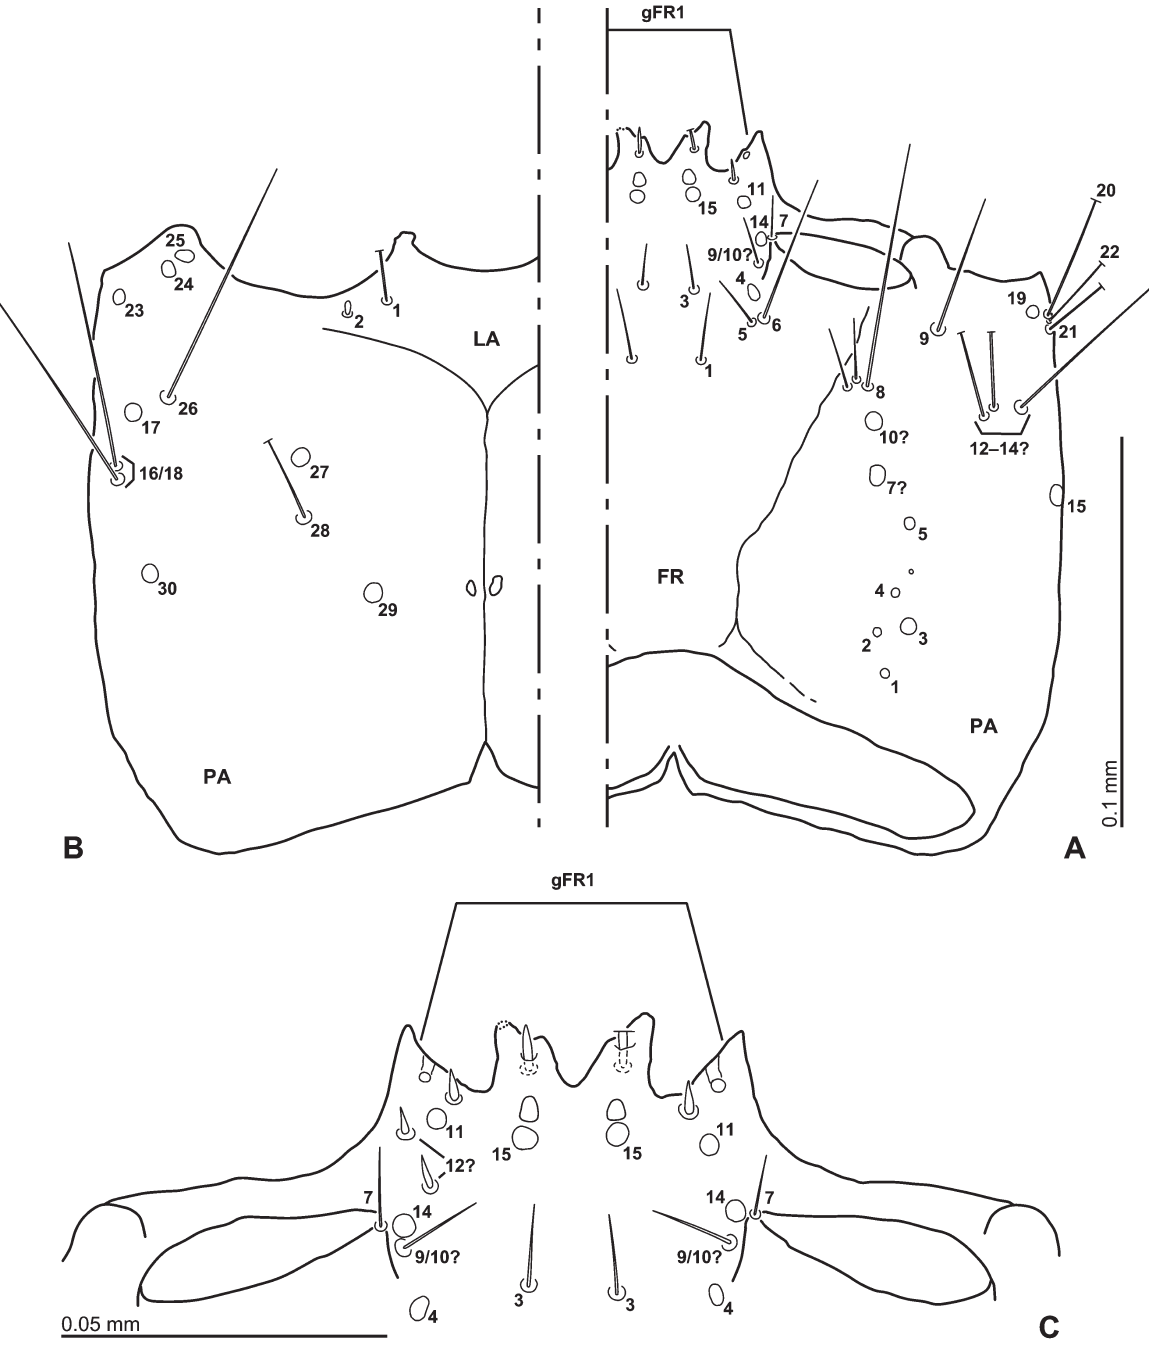
Figure 3. Larva of Psalitrus yamatensis Hoshina & Satô. A, B. Head capsule, dorsal ( A ) and ventral ( B ) view; C. Anterior part of head capsule, dorsal